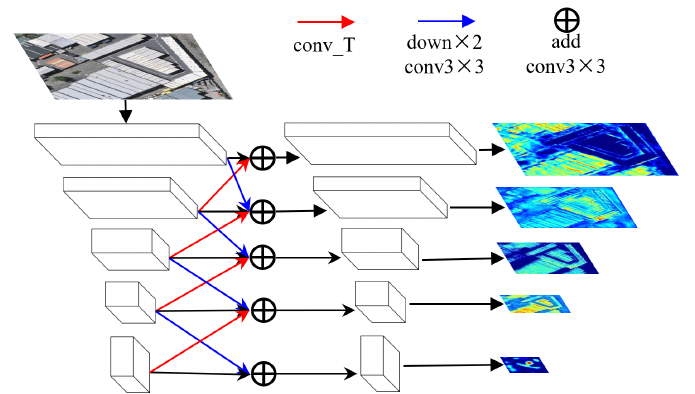
Figure 3. The details of the MFIM. The symbol conv_T indicates deconvolution, down denotes max pooling, and add means elementwise